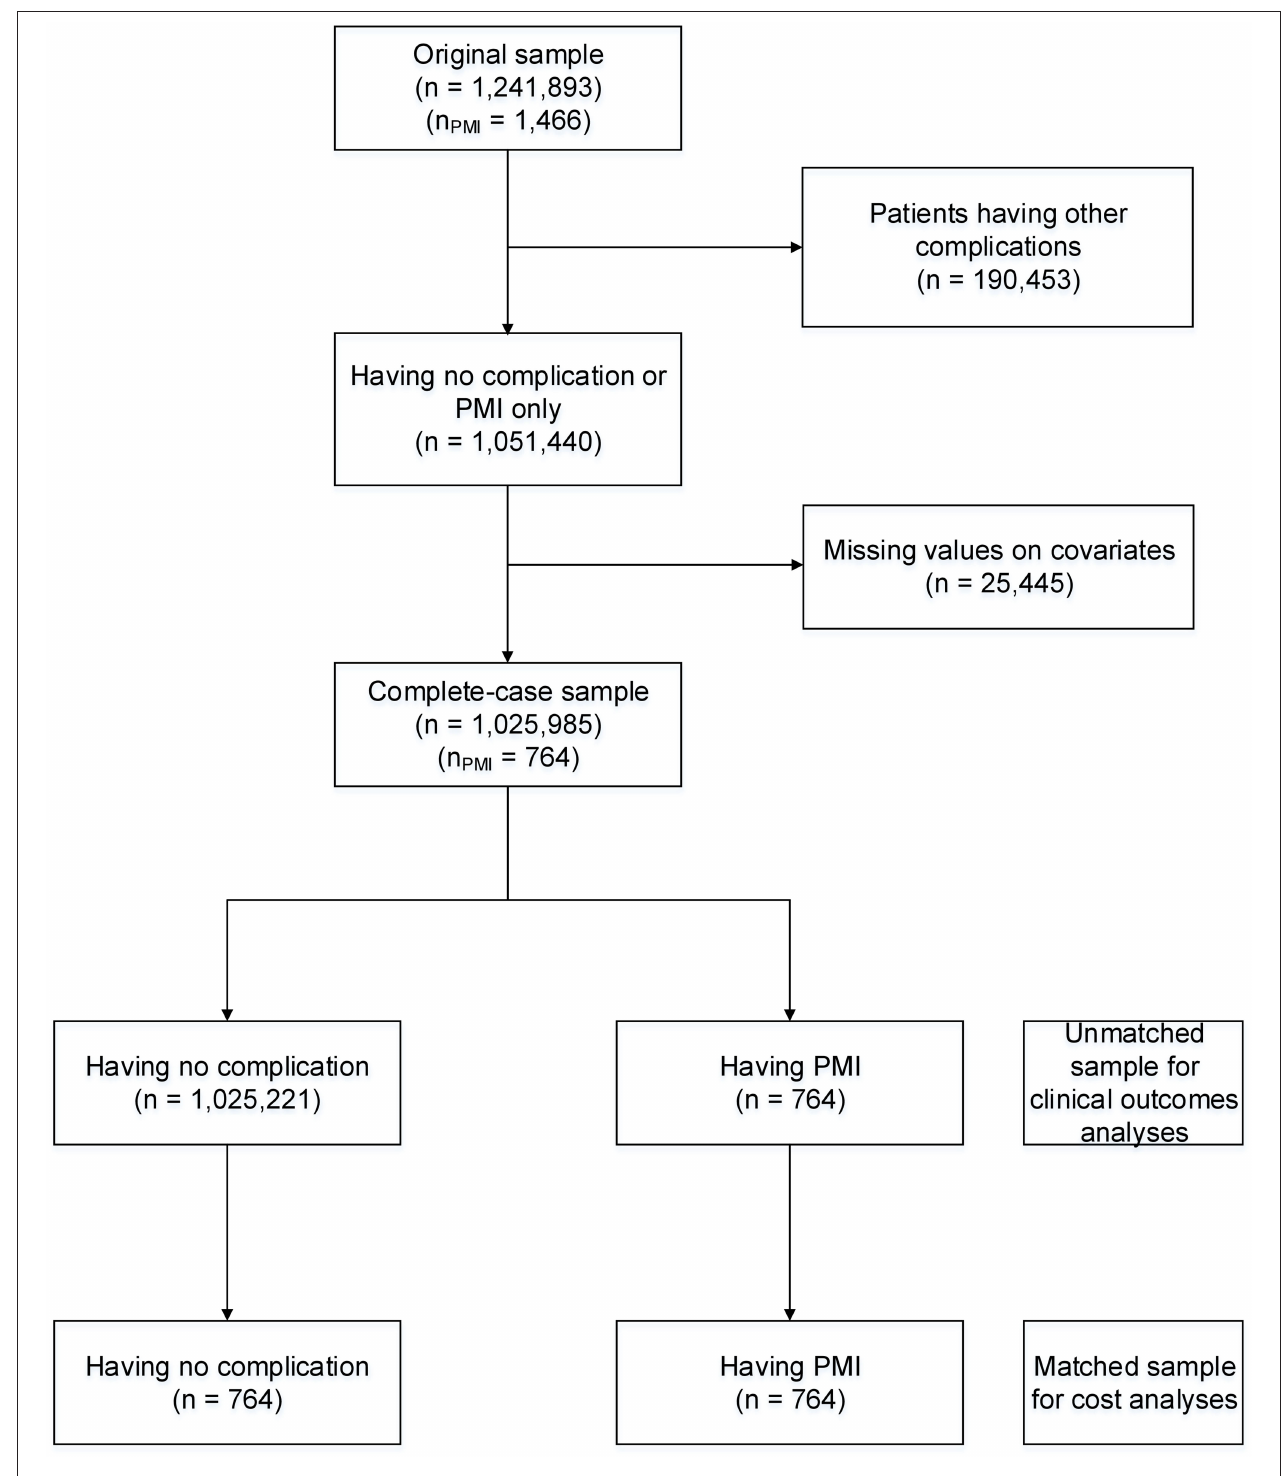
FIGURE 1 | Flow diagram of study sample size. PMI, post-operative myocardial infarction. those who did not have a post-operative complication (OR = 3.45; 95%CI: 2.92–4.08; and OR = 4.39; 95%CI: 3.78–5.10,